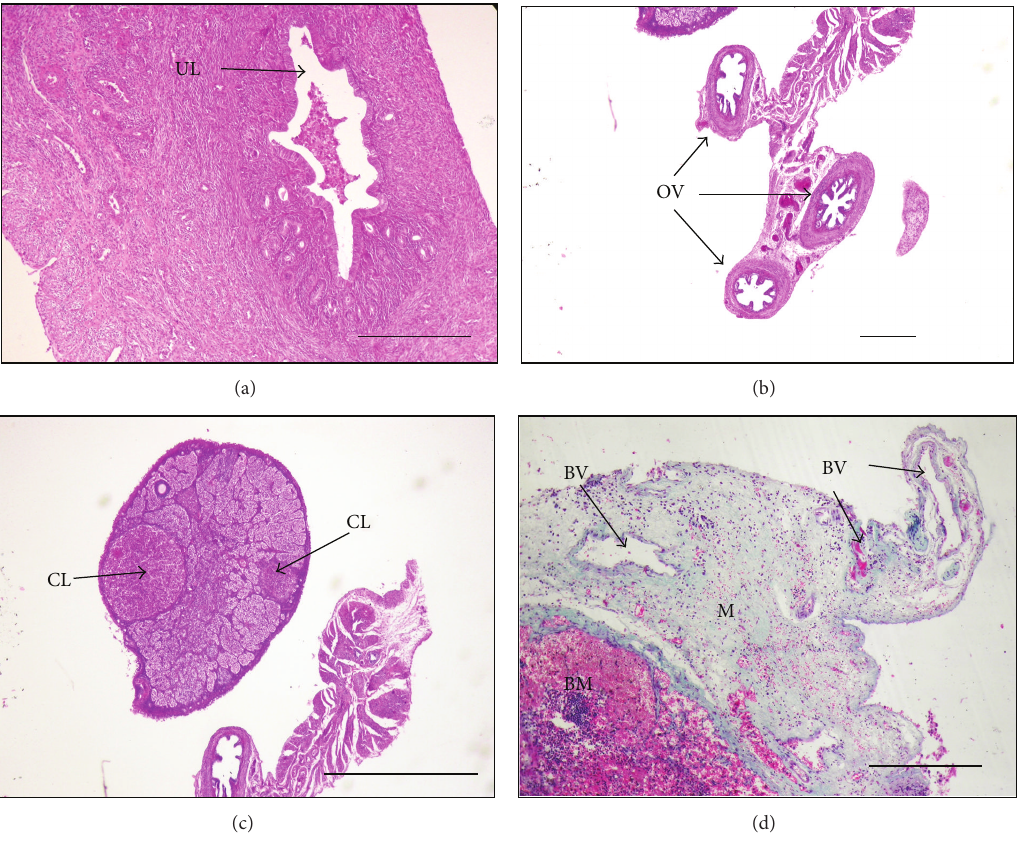
Figure 3: Normal aspect of the maternal reproductive organs. (a) The uterus evidences the endometrial, myometrial, and perimetrial layers. The lumen of the organ (UL) shows the presence of some type secretion. (b) Transversal sections of the oviduct (OV) displaying normal evaginations of the mucosa layer. (c) Transversal section of an ovary showing the presence of two functional corpora lutea (CL) surrounded by multiples degenerative corpora lutea. Figure 3(d) shows mesenchymal tissue (M) organized as a structure with large blood vessels (BV), with the appearance of an umbilical cord attached to the bigger mass (BM). (a, b, and c) H/E staining; (d) PAP staining; bars: (a) = 223 𝜇 m;